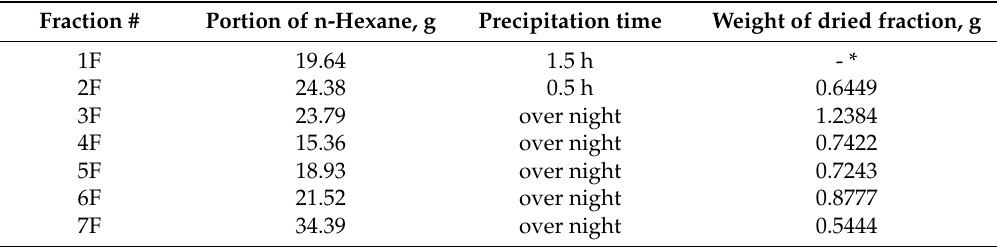
Table 1. Fractionation of